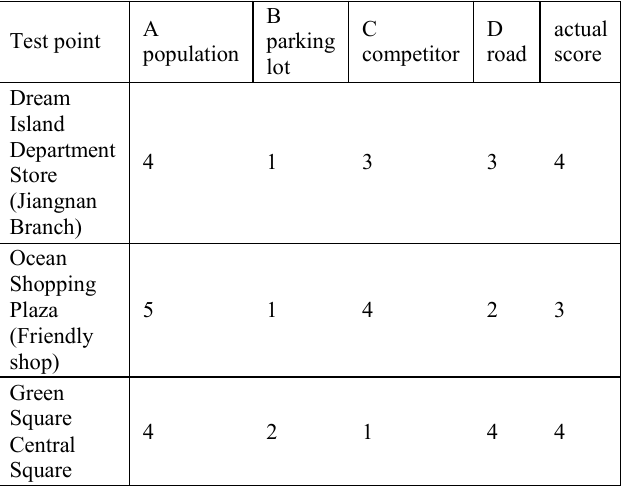
Table 5. Test data sheet After inputting the test data, the input of the neural network is: 4, 3, 4, and the score of the predicted output should be 4, 3, 5. The error of the suitability score S is only 1 when the green square central square data is